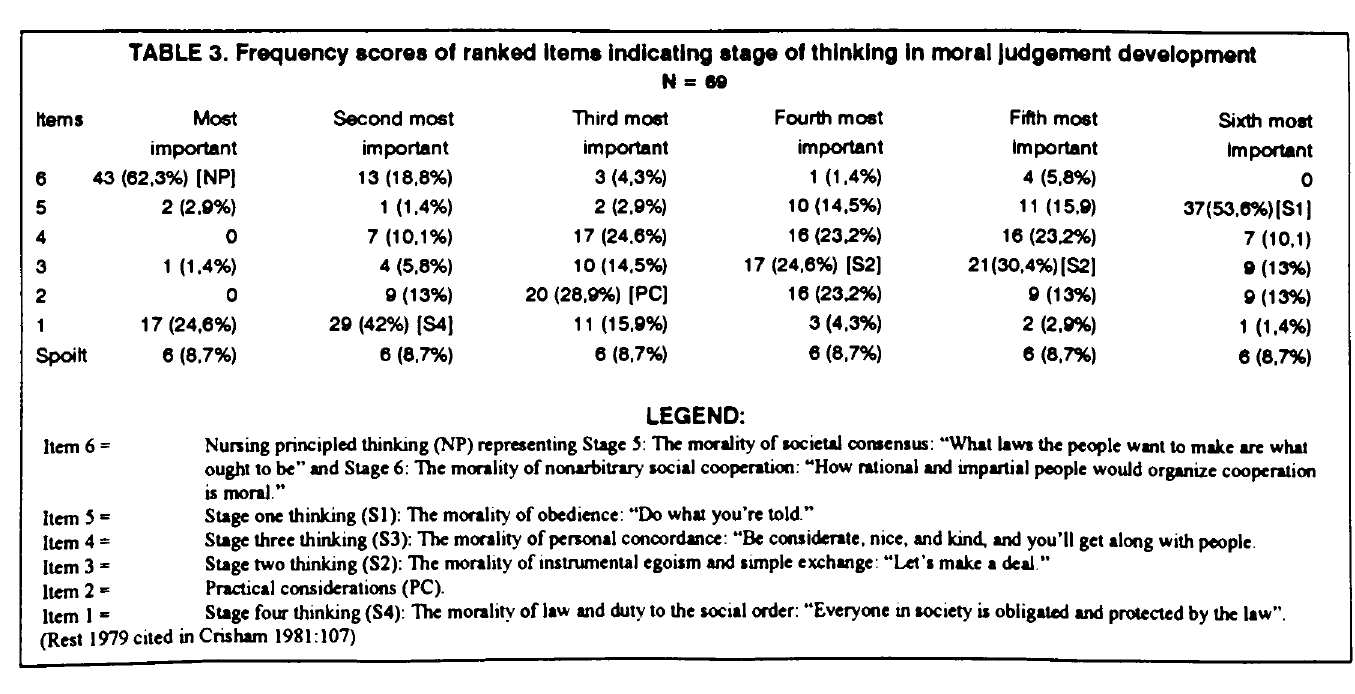
TABLE 3. Frequency scores of ranked Items Indicating stage of thinking In nwral judgement